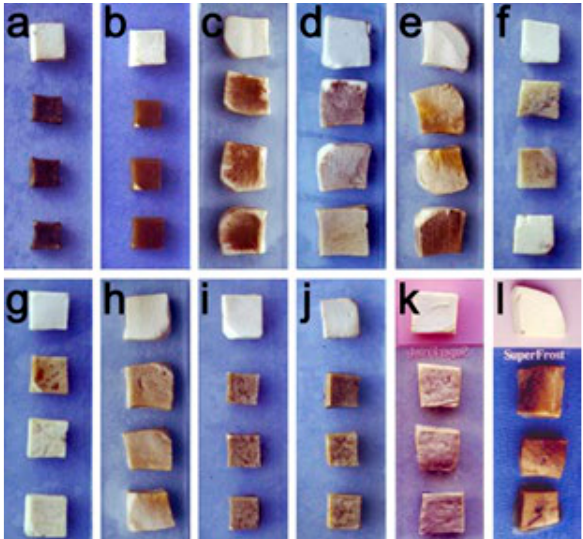
Figure 2. Pathogenicity assays on Agaricus bisporus pseu- do-tissues. Depressed brown discoloration and deliques- cence caused by Pseudomonas tolaasii strain NCPPB2192 (a), marked brown discoloration without deliquescence caused by P. ‘reactans’ strain NCPPB1311 (b) and browning or light discoloration caused by fluorescent Pseudomonas spp. (c, USB34; d, USB36; e, USB44; f, USB45; g, USB52; h, USB53; I, USB55; j, USB56; k, USB111; l, USB113) on A. bisporus pseudo-tissues blocks . The pseudo-tissues block at the top of each pseudo-tissue block set was treated with sterile distilled water as negative